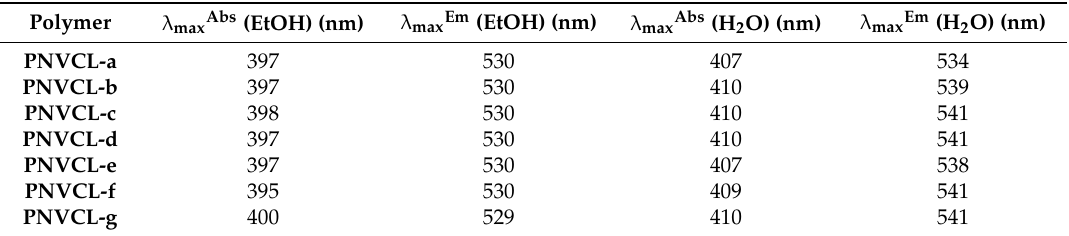
Table 3. Photophysical characteristics of dye-labeled polymers PNVCL-a – PNVCL-g in ethanol and water (21 ˝